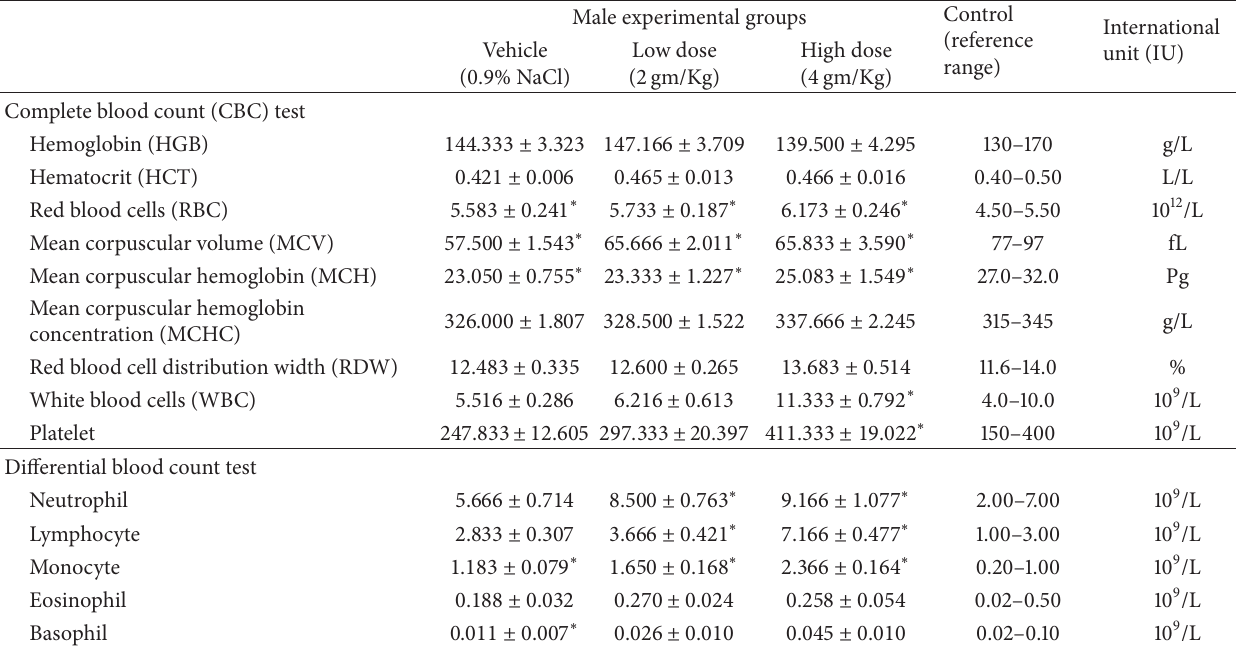
Table 5: Complete blood count and differential blood count tests among male rats.